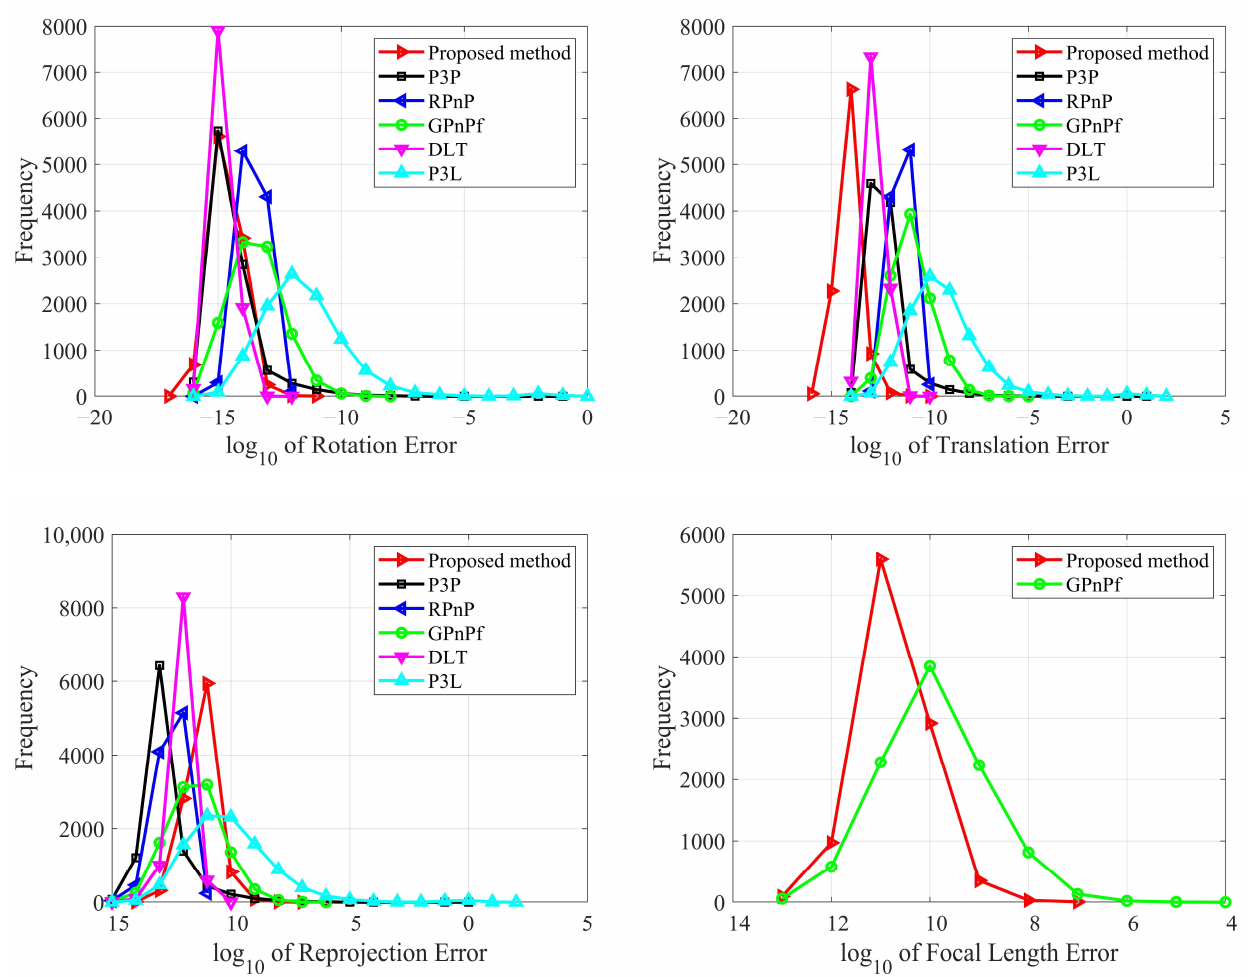
Figure 6. Numerical stability for our proposed method (Red), P3P (Black), RPnP (Blue), GPnPf (Green), DLT (Purple) and P3L (Cyan). The top left is the rotation error, the top right is the translation error, the bottom left is the reprojection error, and the bottom right is the focal length error.